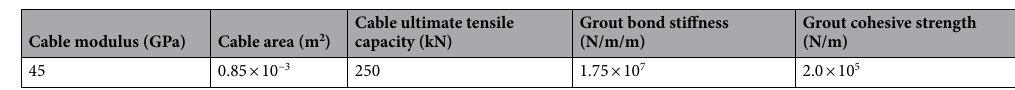
Table 10. Parameters used for cable